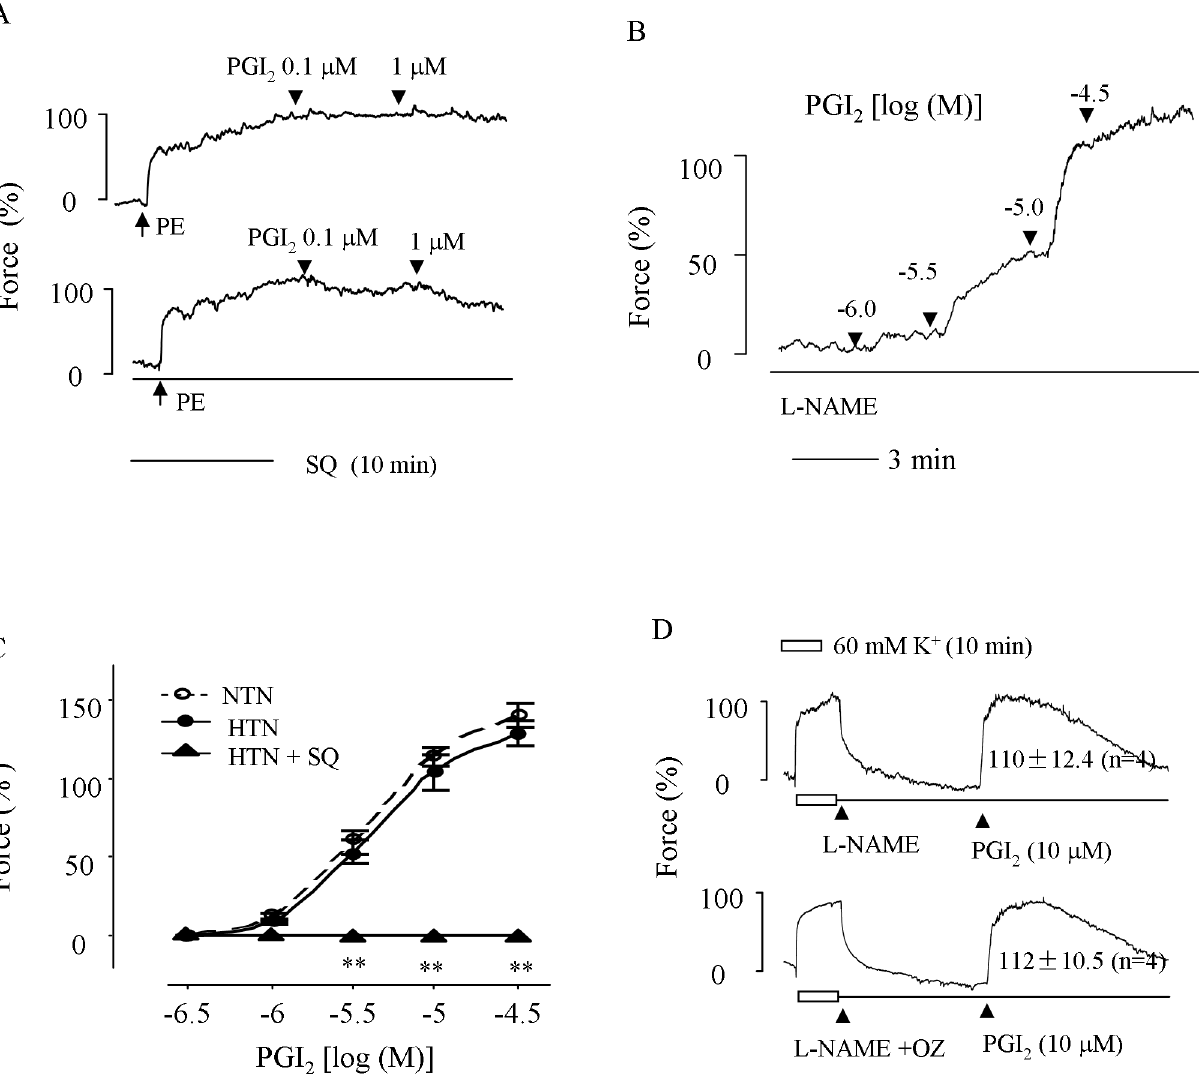
Fig 3. Vasomotor reaction to PGI 2 in HTN carotid arteries. A : representative traces showing the response evoked by 0.1 – 1 μ M PGI 2 in intact (untreated with L-NAME) HTN carotid arteries pre-contracted with 1 μ M PE in the absence (top) or presence (bottom) of 3 μ M TP receptor antagonist SQ29548 (SQ). B : a representative trace showing the contraction evoked by PGI 2 (1 – 30 μ M) in L-NAME-treated HTN carotid arteries. C : summary of contractions evoked by PGI 2 (1 – 30 μ M) in L-NAME-treated HTN as compared to those of NTN arteries or those of HTN vessels obtained in the presence of 3 μ M TP receptor antagonist SQ29548 (HTN+SQ). Values were expressed as mean ± SEM (n = 5 for each); ** P < 0.01. D : representative traces with summarized values showing contractions evoked by PGI 2 (10 μ M) in L-NAME-treated HTN arteries in the absence (top) or presence (bottom) of 3 μ M TXAS inhibitor ozagrel (+OZ). Values were expressed as mean ± SEM (n = 4 for each); P >